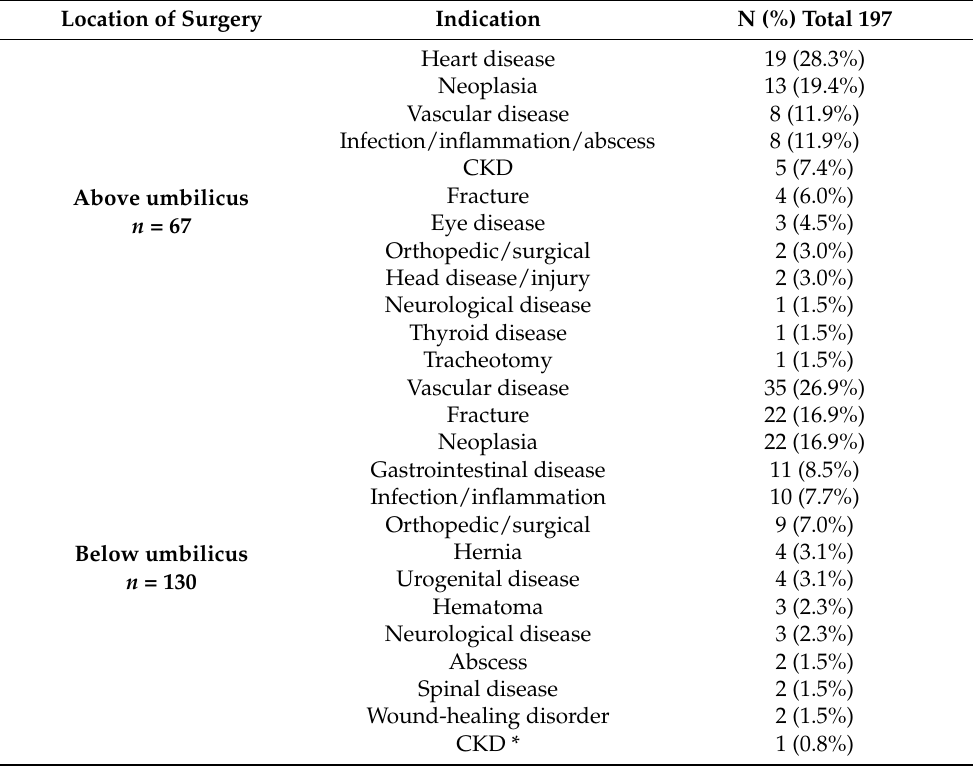
Table 6. Indications for surgery or